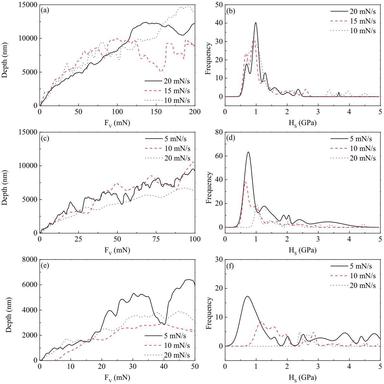
Depth (a, c and e) and hardness distributions (b, d and f) of the LIL scratches: (a and b) 200 mN with the loading rates of 10, 15, and 20 mN/s; (c and d) 100 mN and (e and f) 50 mN with the loading rates of 5, 10, and 20 mN/s.